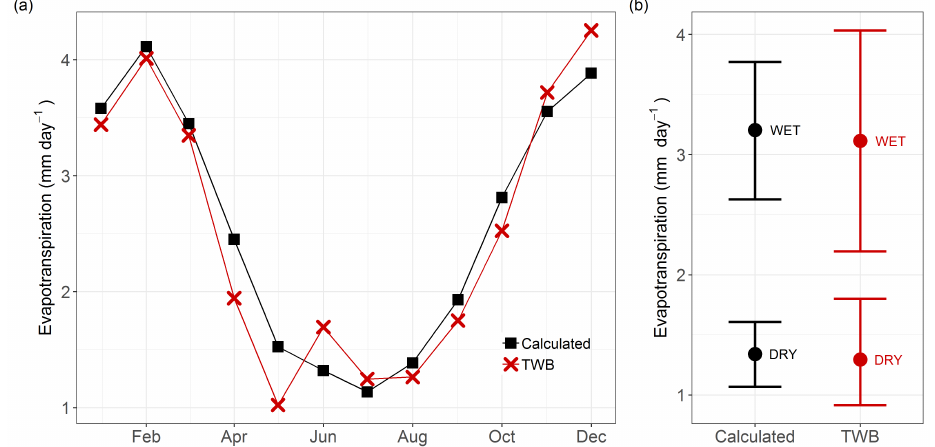
Figure 5. ( a ) Mean monthly ET, in mm d − 1 , calculated by the model (black squares) and estimated by TWB (red crosses). ( b ) ET average (points) and 75th and 25th percentiles (bars), in mm d − 1 , for each estimate in dry (May to Aug) and wet (Sep to Apr) seasons. Panels use the common period for model and